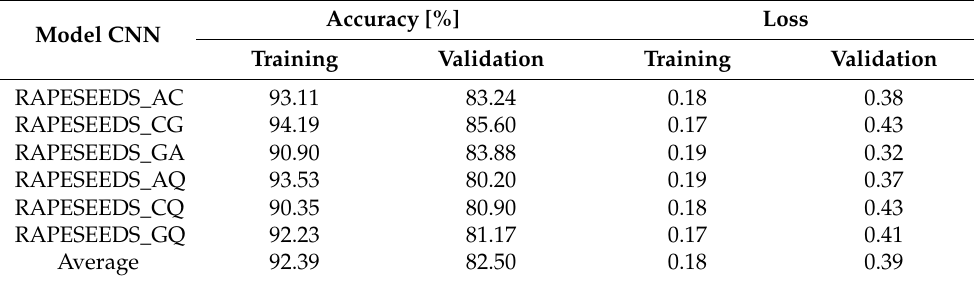
Table 4. Average accuracy and loss values of the training and validation process for CNN models in 30 epoch.